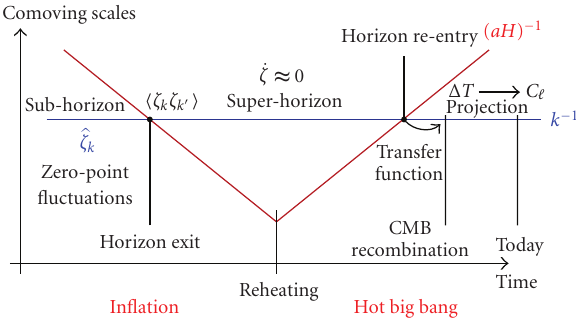
Figure 2: Evolution of comoving horizon and generation of perturbations in the inflationary universe. figure is from